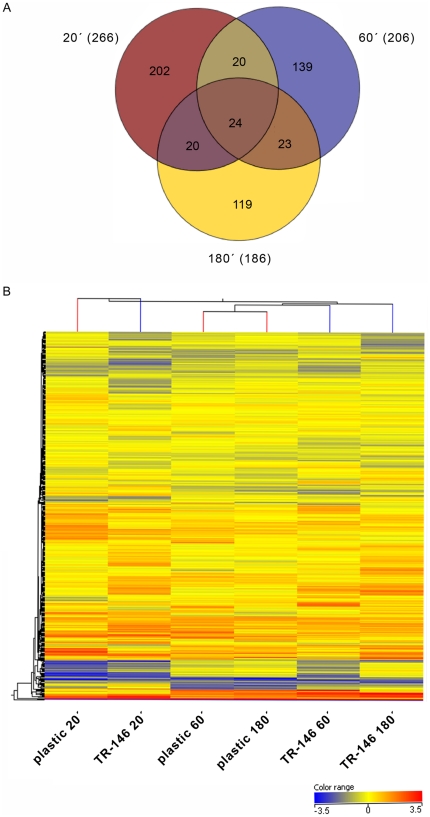
Distribution of differentially regulated genes and hierarchical
clustering.(A) Venn diagram showing the distribution of the differentially regulated
genes from C. albicans cells grown on epithelial
monolayer at 20, 60 and 180 min after horizontal analysis as compared to
plastic. (B) Hierarchical clustering of C. albicans
genes expressed at 20, 60 and 180 min incubation on oral epithelial
cells versus plastic. Gene expression is shown in a logarithmic color
range from −11.31 in blue to 11.31 in red. Non regulated genes (1)
are shown in yellow. The profiles of the earliest time points cluster
more distant to the later time points. The expression profiles of
C. albicans exposed to epithelial cells at 20, 60
and 180 min did not show any clear similarities. In contrast, the
profiles of cells exposed to plastic for 60 and 180 min were most
similar to each other as compared to all other samples.